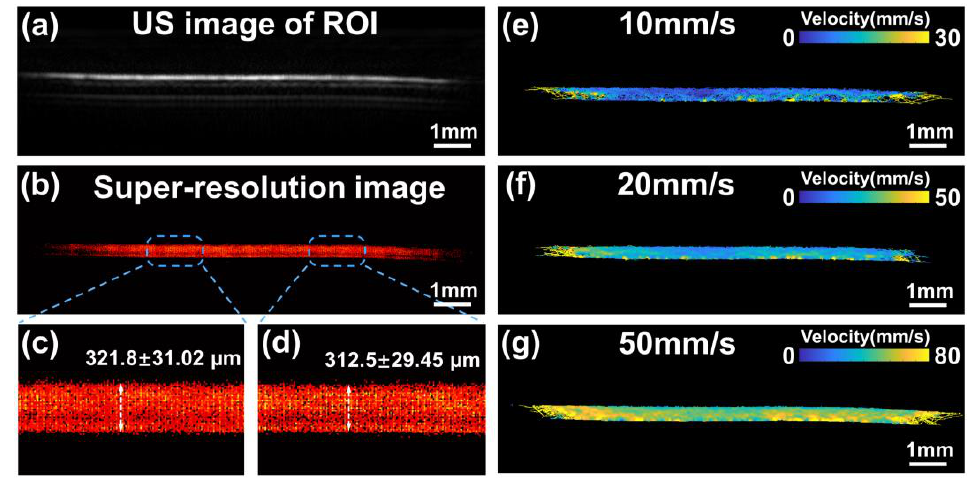
Figure 7. ( a , b ) The US image and the super-resolution image of the flow phantom. ( c , d ) The zoom-in views of the box regions in ( b ). ( e – g ) The reconstructed flow velocity map at 10 mm/s, 20 mm/s, 50 mm/s.